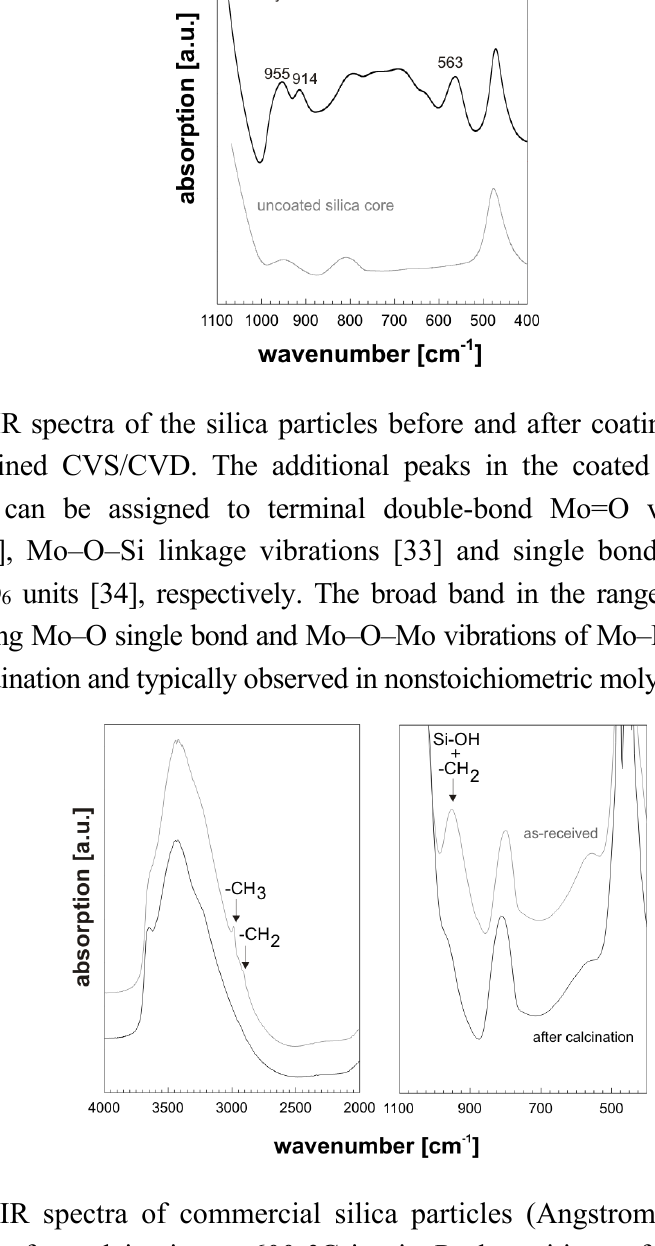
Figure A2. FTIR spectra of commercial silica particles (AngstromSphere™) measured as-received and after calcination at 600 °C in air. Peak positions of organic residues are indicated. The peak around 960 is attributed to surface hydroxyl groups and –CH2